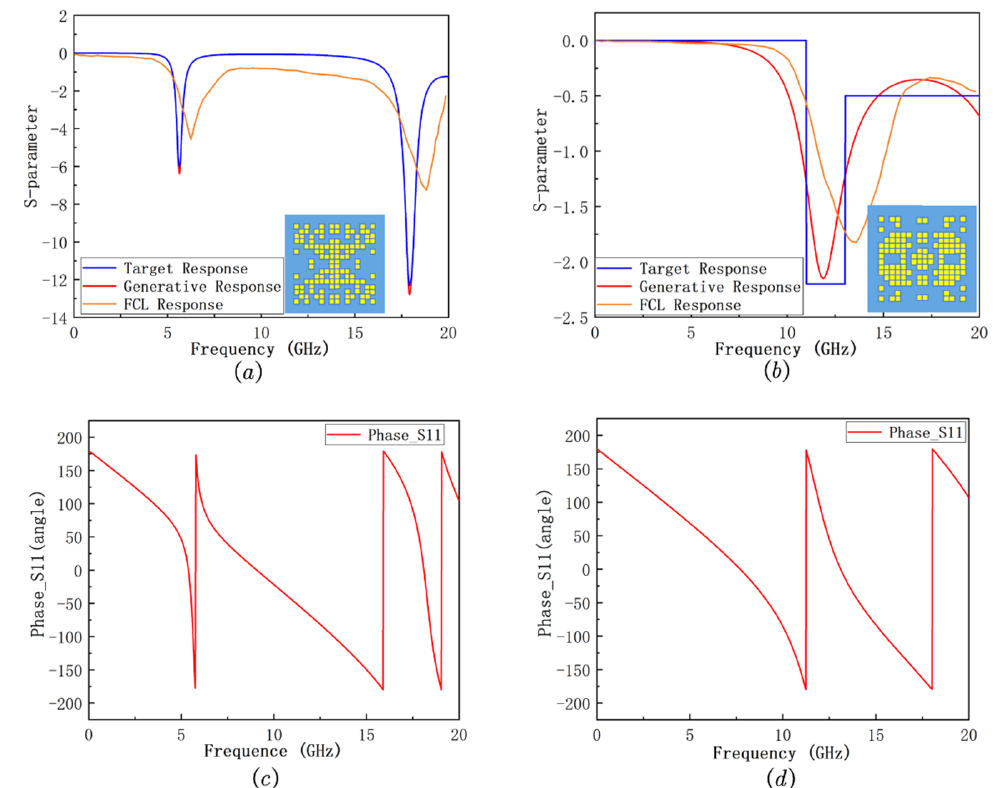
Figure 11. ( a , b ) Input the target EM response into the framework. ( c , d ) Phase curves corresponding to the metasurfaces of ( a , b ).